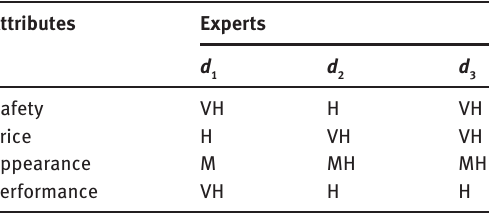
Table 2. Weights of the Attributes Evaluated by the Experts.